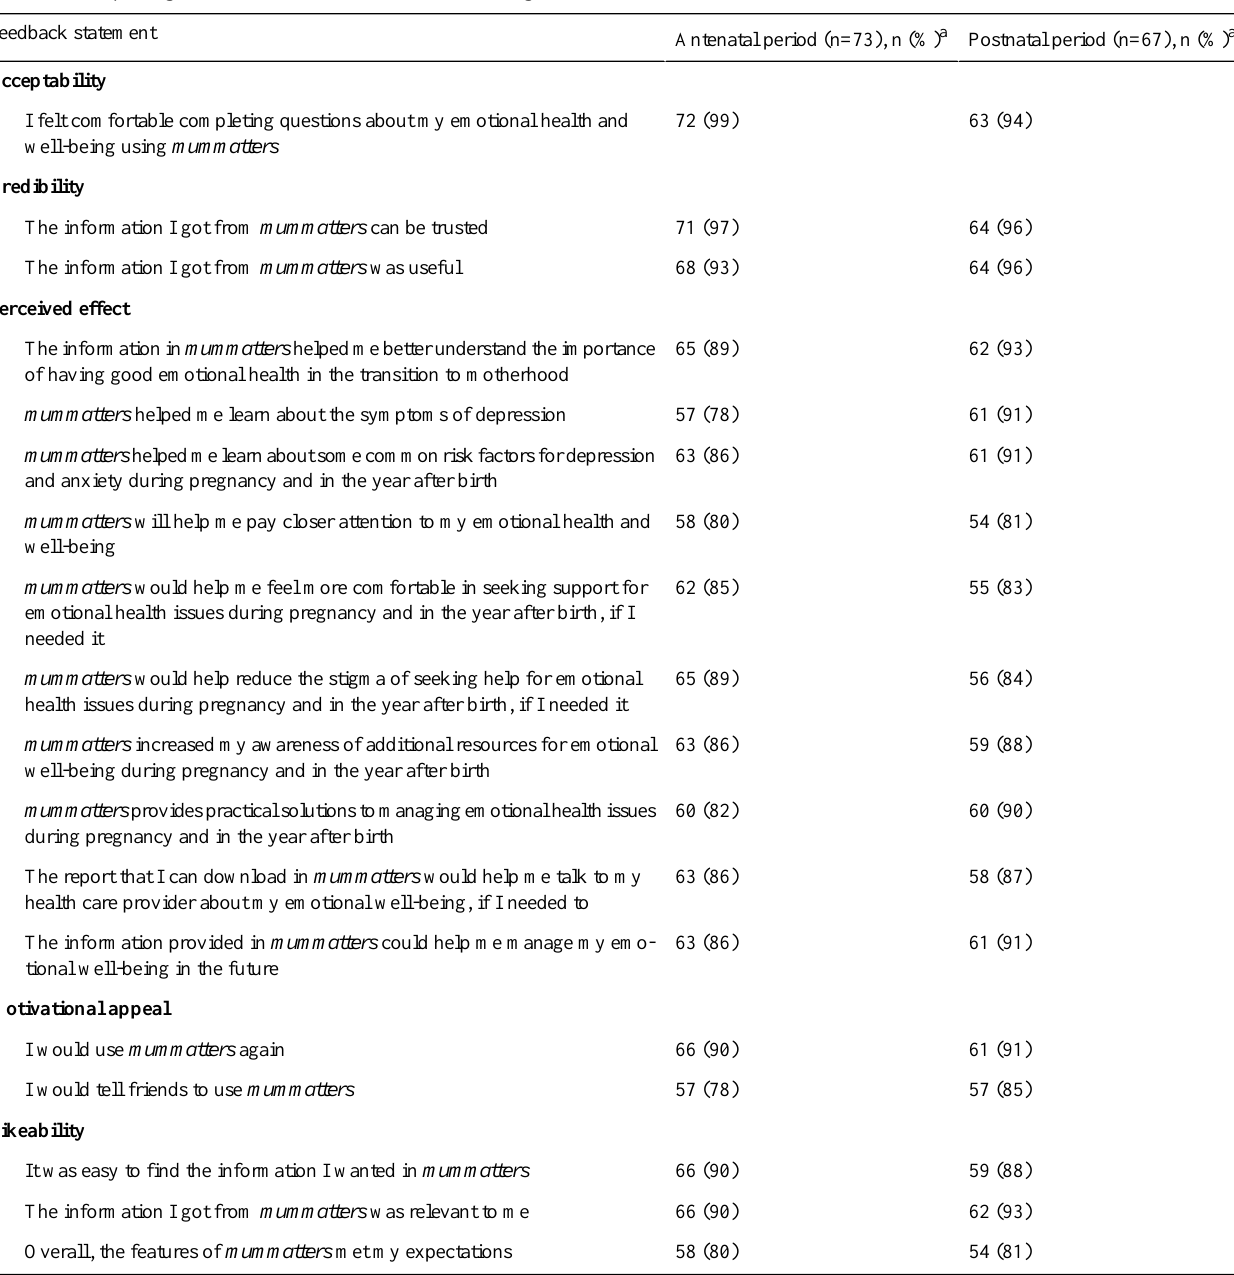
Table 3. Participant agreement with feedback statements relating to the use of